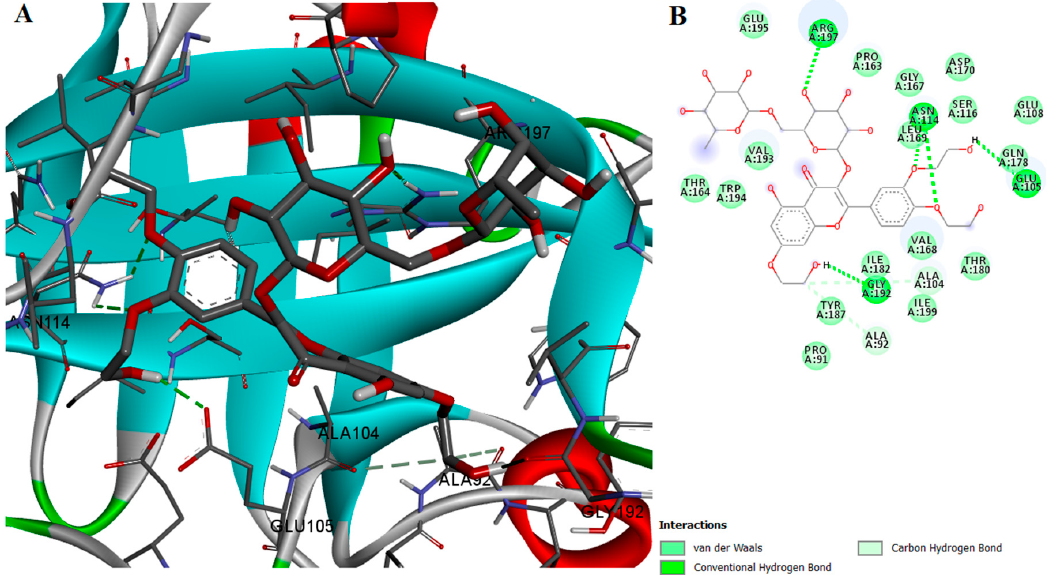
Figure 7. ( A ) Docked conformation and interactions of the troxerutin-SrtA complex; ( B ) 2D diagram of the predicted interactions; backbone of the protein is colored in grey, β -helices in turquoise, α -helices in red and loops in green. Ligand-protein interactions are colored depending on their type: conventional hydrogen bonds are colored in green, π - σ and π -alkyl interactions are colored in purple and light purple, respectively.